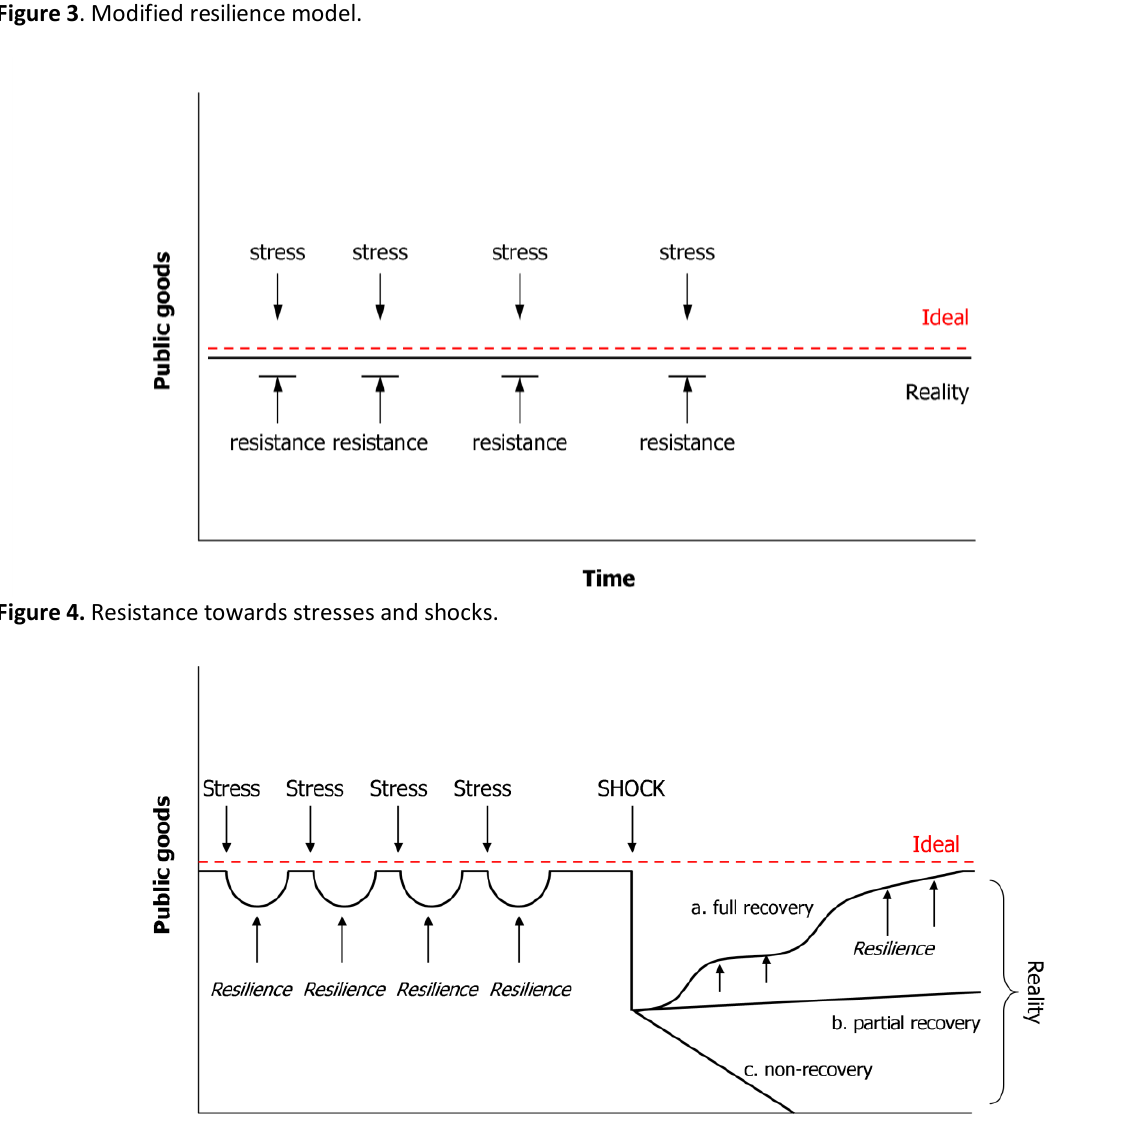
Figure 5. Resilience towards repeated stresses and shocks. Note: An earlier version was used in IRISS Deliverable